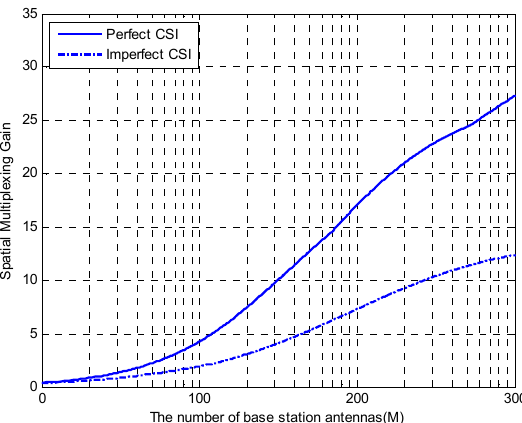
Figure 6. Spatial multiplexing gain vs. the number of BS antennas in multi-cell system with L = 7, K = 10, transmit power =10 dB.